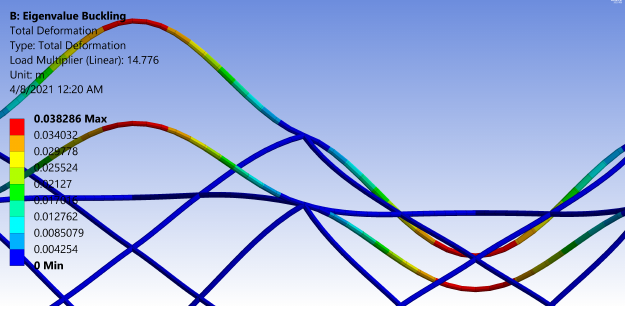
Figure 21. Rotation at the nodes of an IsoTruss structure with thirteen carbon tows per helical member